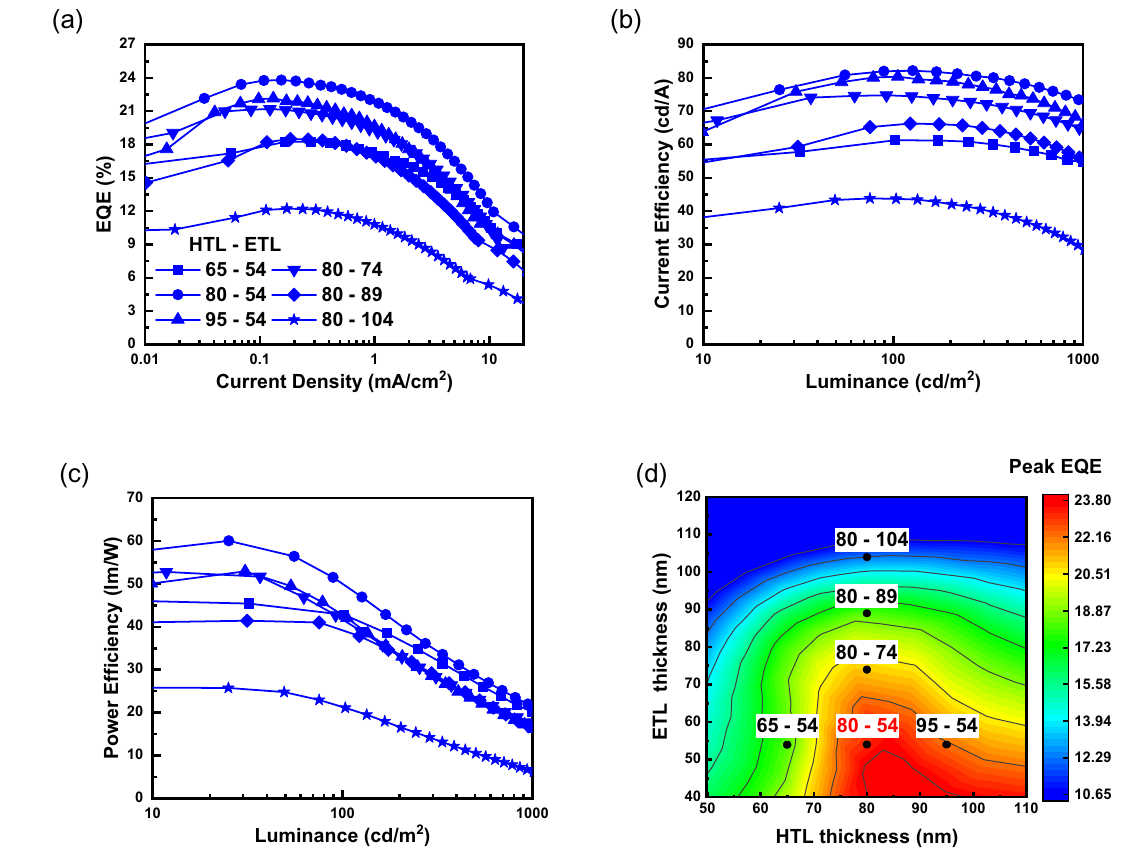
Figure 5. EL characteristics of six representative devices: ( a ) current density–EQE (J – EQE) characteristics, ( b ) current efficiency–luminance (CE–L) characteristics, and ( c ) power efficiency–luminance (PE–L) characteristics. ( d ) EQE contour plot of all the fabricated OLEDs with various HTL and ETL thickness (the dots are data of the six-representative device).